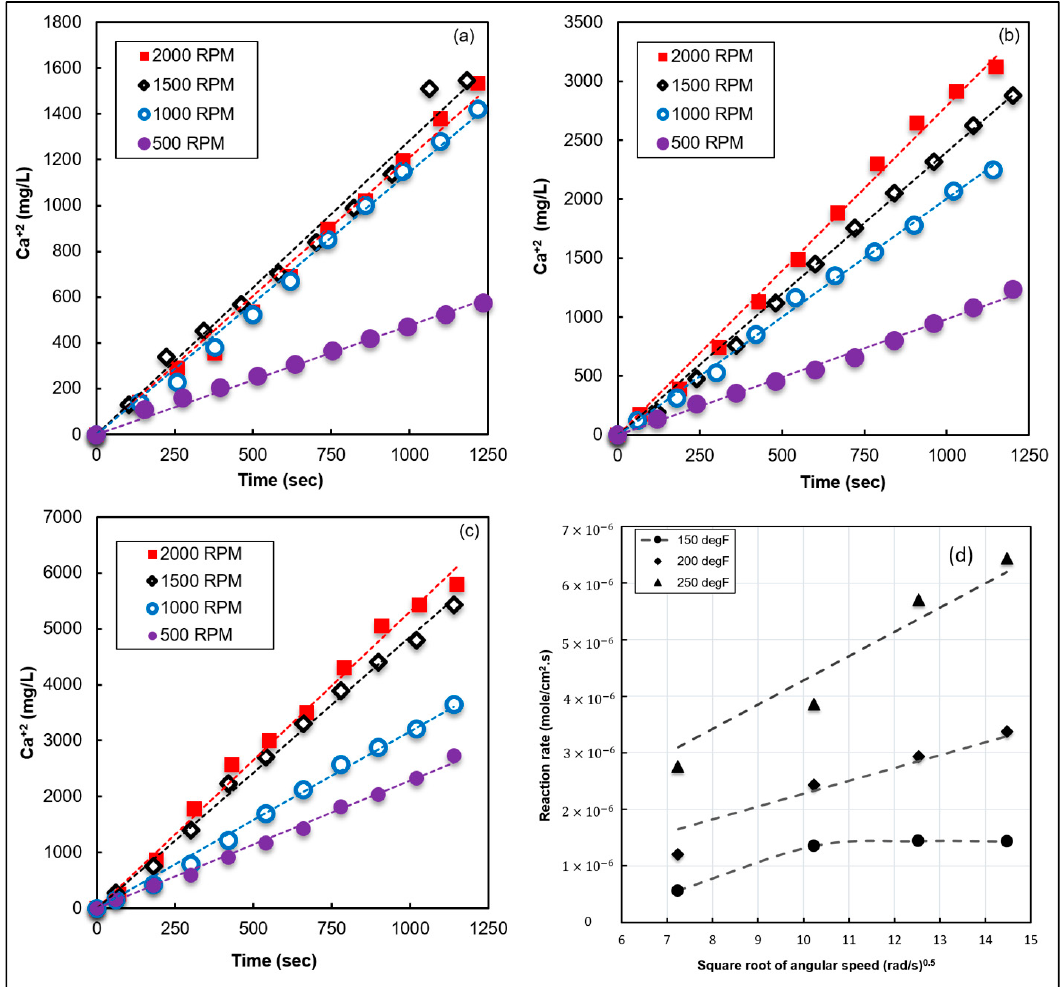
Figure 6. The concentration of calcium in the collected fluid samples as a function of time and rotation speed using 20 wt% GLDA/DI solution at 150 °F ( a ), 200 °F ( b ), and (250 °F) ( c ), and rate of calcite dissolution in 20 wt% GLDA/DI at pH 3.8 at corresponding temperatures ( d ).